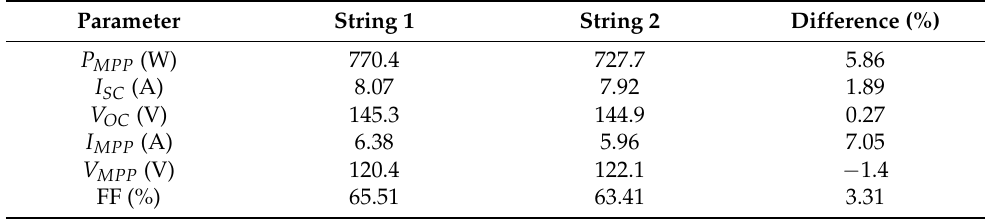
Table 2. Measured electrical parameters at 827 W/m 2 solar irradiance and a PV surface temperature of 23.3 °C.